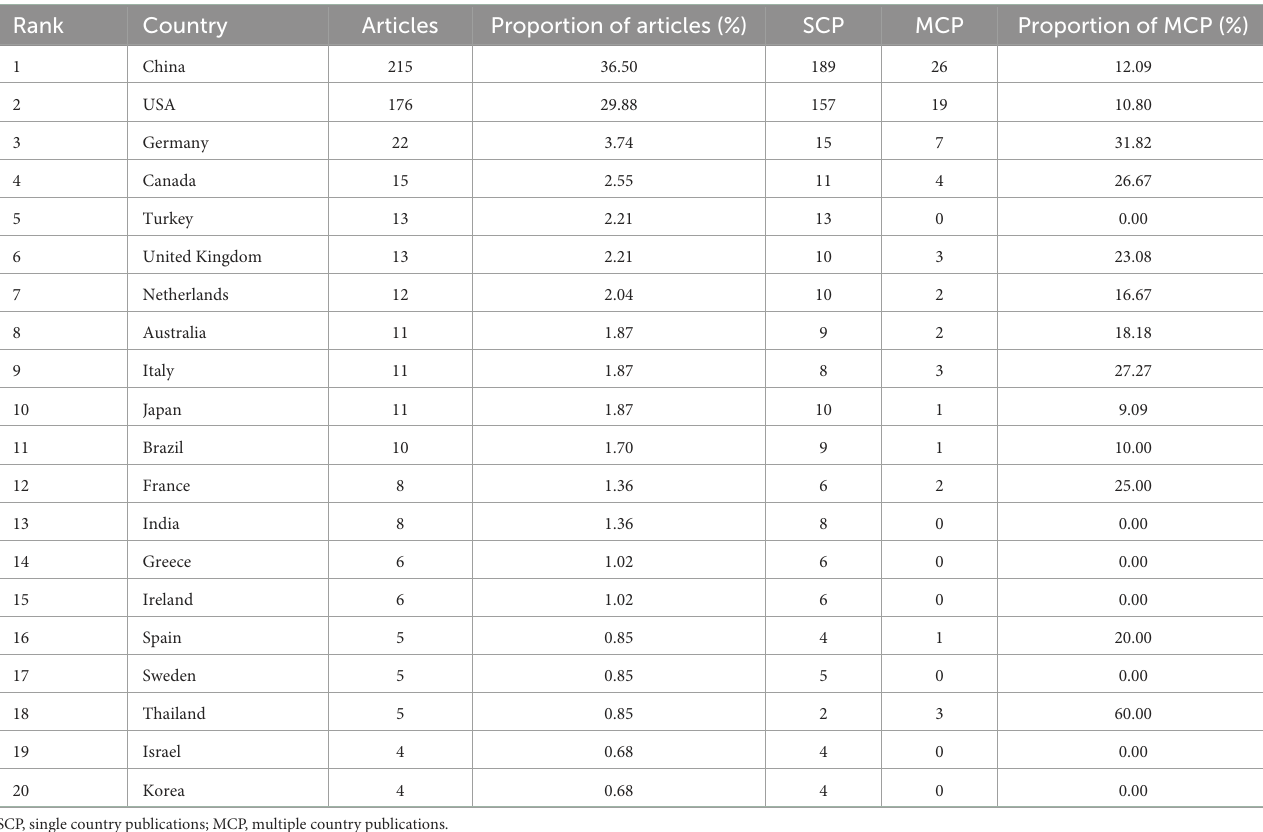
TABLE 1 Top 20 countries production and collaboration based on the nationality statistics of the corresponding authors in gut microbiota and trauma research.